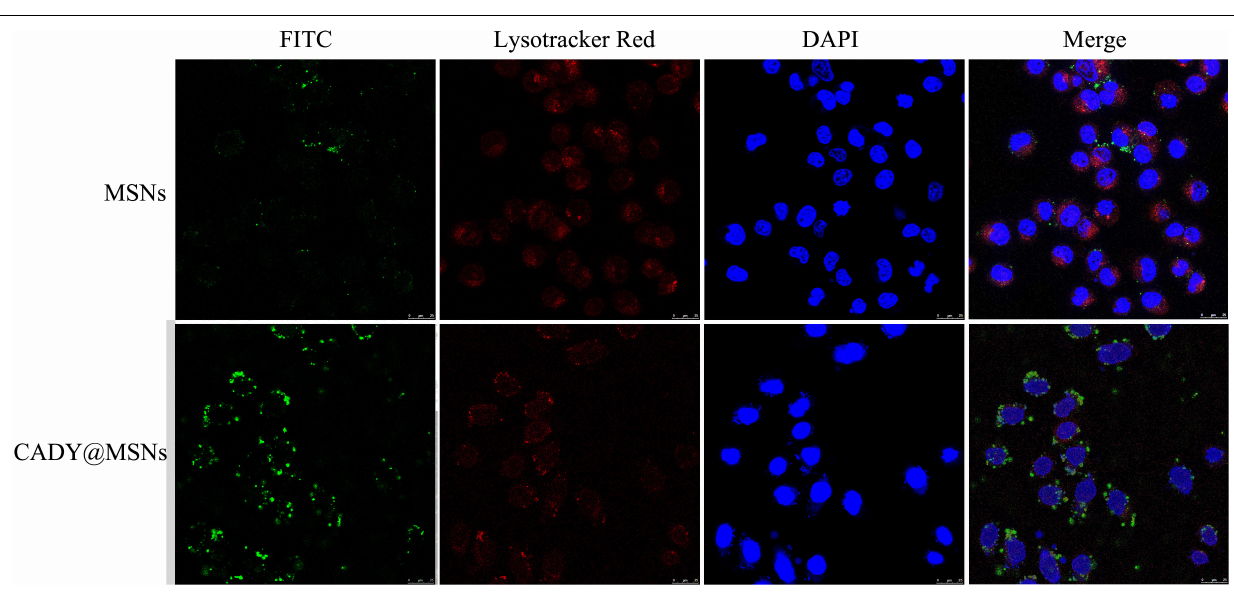
FIGURE 5 | Internalization characteristics of FITC-labeled MSNs and FITC-labeled MSNs@CADY by HFLS cells treated for 12 h, as observed by confocal laser scanning microscopy. Cells were stained with DAPI and LysoTracker Red